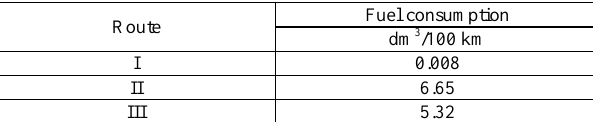
Table 3. CO, HC, NO x and PM net road emissions during road measure- ments throughout the whole test Route